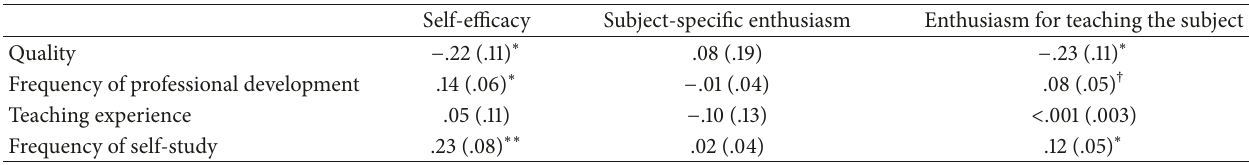
Table 4: Unstandardized regression coefficients (standard errors in parentheses) for teachers’ self-efficacy as well as enthusiasm and the considered opportunities to